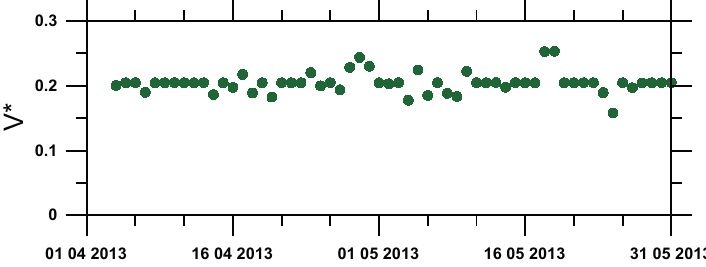
Figure 2. Daily depolarization calibration factor V ∗ as derived during